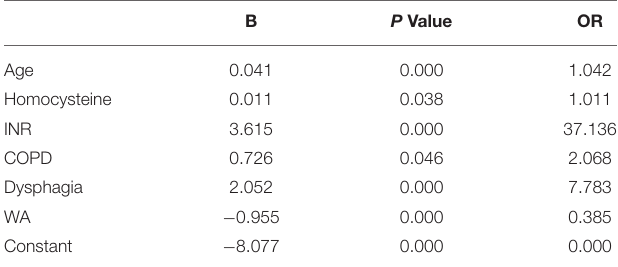
TABLE 3 | Logistic regression model results.